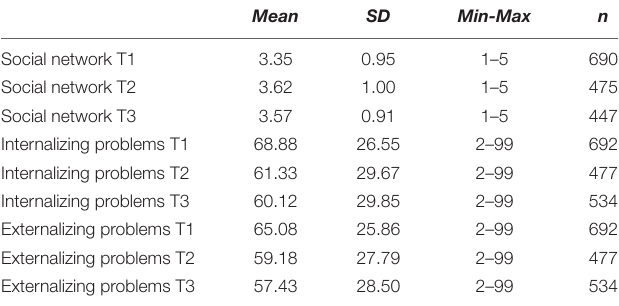
TABLE 1 | Means and standard deviations of social network and